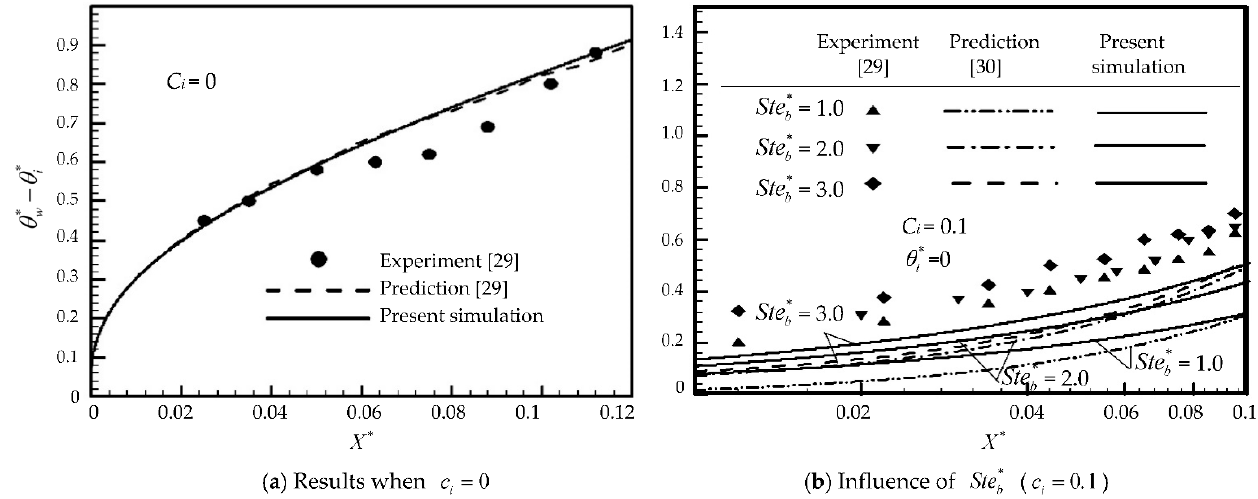
Figure 3. Comparison of the predicted wall temperature with the experimental and analytical results in the literature [29,30] shows that there was no significant difference.